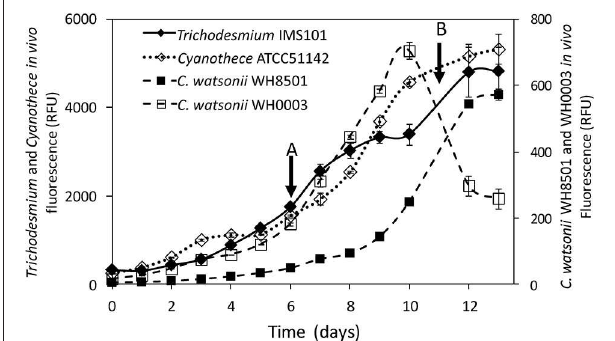
FIGURE 1 | Evolution of the in vivo Chl a fluorescence (in relative fluorescence units) in Trichodesmium IMS101, Cyanothece ATCC51142, C. watsonii WH8501 and WH0003 cultures. Error bars represent the standard deviation of triplicate measurements and the propagated analytical error. Black arrows represent the start of the diel cycle experiments (exp 2): on day 6 in Cyanothece and C. watsonii WH0003 cultures (A), on day 11 in Trichodesmium and C. watsonii WH8501 cultures